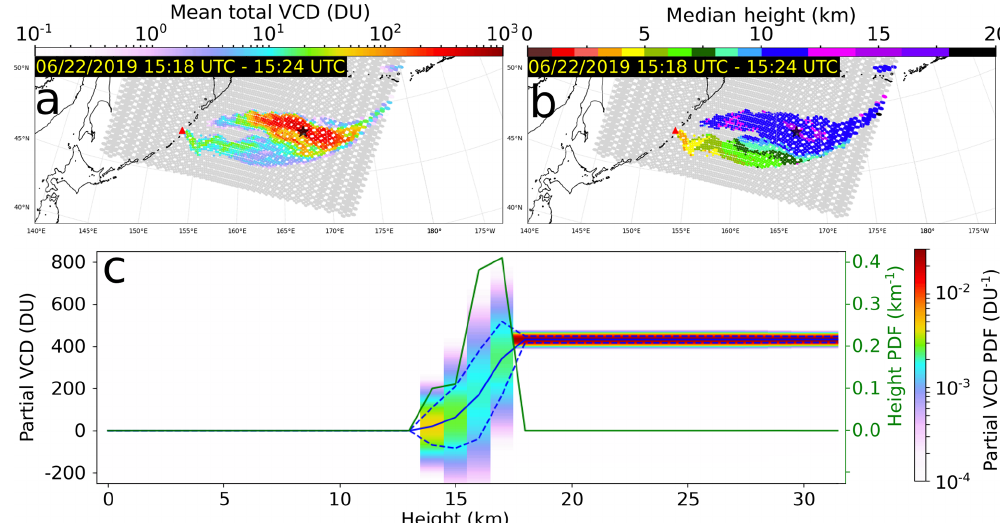
Figure 5. NOAA-20 CrIS mean total VCD (a) and median height (b) early in the evolution of the Raikoke eruption cloud. The star indicates the location of panel (c) . (c) Probabilistic retrieval of SO 2 layer altitude (PDF, green) and partial VCD (mean, solid blue; mean ± standard deviation, dotted blue; PDF, color bar) for the strongest individual VCD measured by CrIS in the Raikoke cloud (48.52107 ◦ N, 167.25615 ◦ W; 22 June 2019,